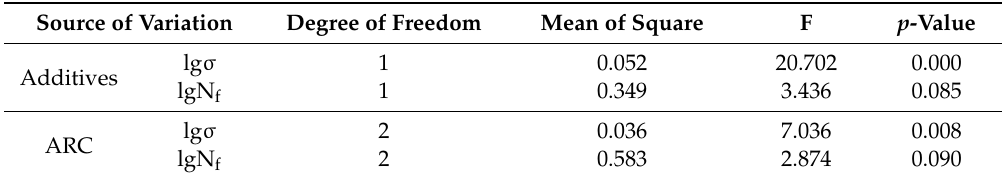
Table 12. ANOVA Results for Fatigue